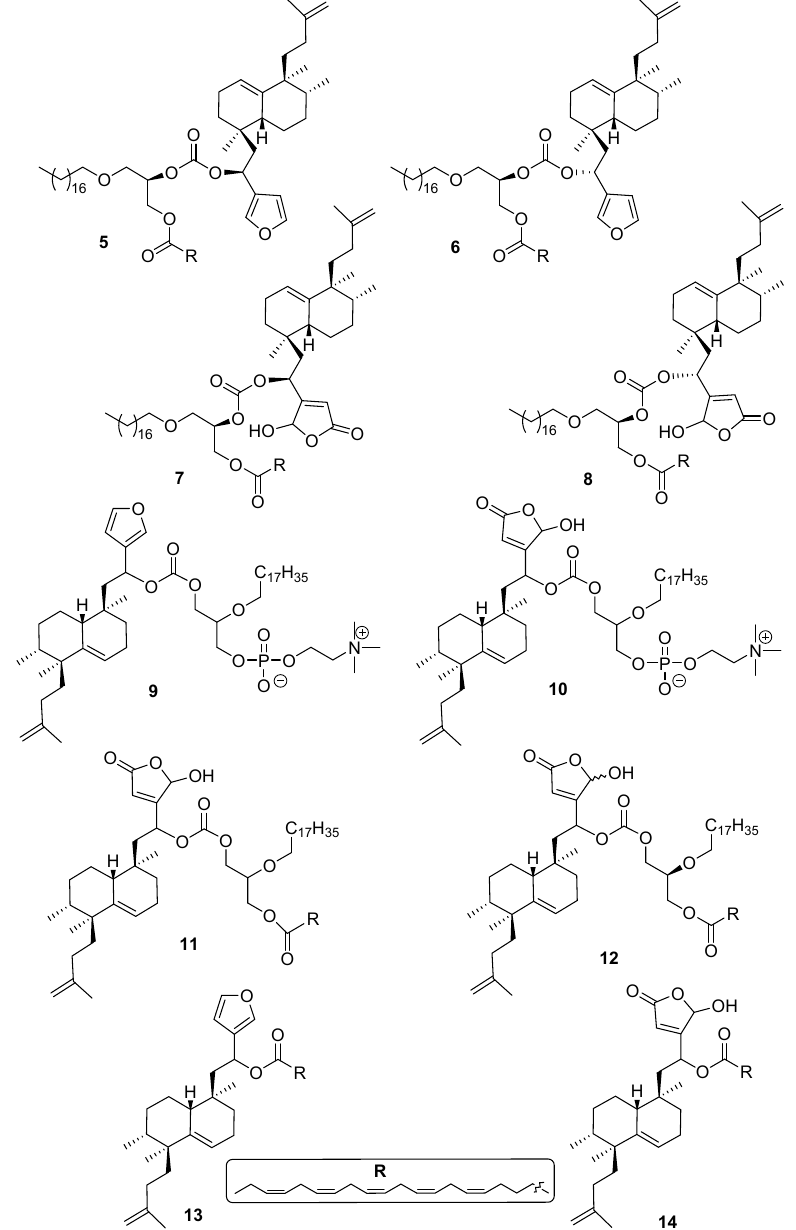
Figure 2. Alkyl glycerol sesterterpenoids bioconjugate compounds 5 – 12 and sesterterpenoid-PUFAs 13 – 14 , synthesized in this work.